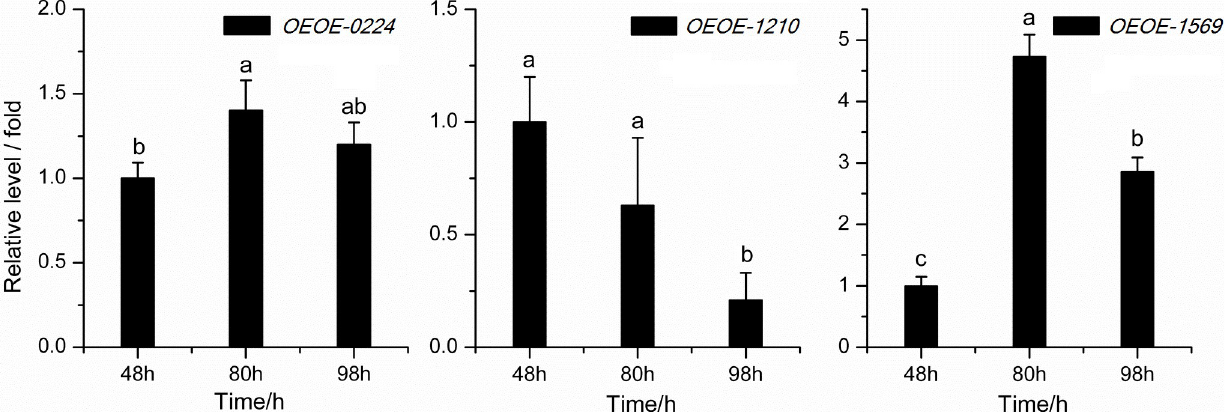
Fig 3. Expression levels of bgl gene in O . oeni SD-2a at different growth phase. Note: The sample at 48h represented 1 × expression of target gene.